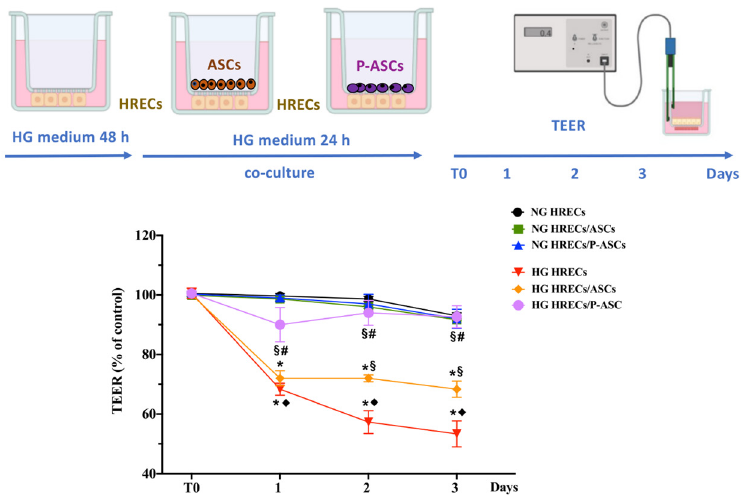
Figure 1. Evaluation of blood–retinal barrier integrity by transendothelial electrical resistance (TEER) in monocultures of human retinal endothelial cells (HRECs) and in co ‐ cultures of HRECs with adipose ‐ derived mesenchymal stem cells (ASCs) or pericyte ‐ like differentiated ASCs (P ‐ ASCs). In the upper part of the figure, TEER measurement procedures are illustrated. HRECs were first seeded in the underside of transwell inserts. In some samples, glucose was added to mimic hyperglycemic (HG) conditions. After 48 h, ASCs or P ‐ ASCs were also seeded on the topside. TEER values were initially measured after 24 h of co ‐ culture (T0), and for the following 3 days. In some other samples, TEER measurements were carried out on corresponding cultures maintained in normal glucose (NG) conditions. TEER values were also measured in cultures of HRECs alone, in NG or HG conditions, at corresponding time points. The results obtained are reported in the graph in the lower part of the figure. For each sample, data are expressed as percentage changes with respect to the value measured at T0, assumed as a control. As was expected, no significant variations were observed in samples kept in NG conditions. Instead, different changes were found for the various HG samples: the most evident decreases were exhibited by HG HRECs; except for day 1, lower decreases were noticeable when HRECs were co ‐ cultured with ASCs; minimal decreases were observed when P ‐ ASCs were also present. In fact, in the last case, no significant variations were revealed at day 2 and 3, compared with NG conditions. Values are expressed as the mean ± standard error of the mean (SEM) of results from three independent experiments, with four parallel samples per group in each experiment. * p < 0.05 vs. T0 (starting point of measurements); p < 0.05 vs. NG respective controls (CTRL); § p < 0.05 vs. respective HG; p < 0.05 vs. HRECs/ASCs ‐ conditioned